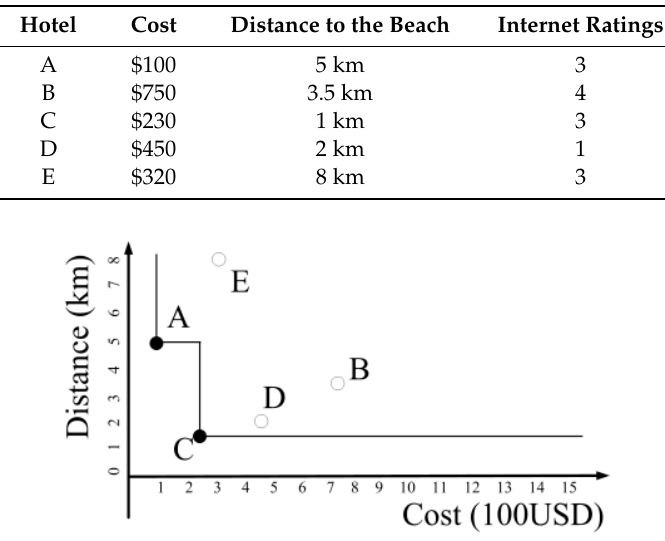
Table 2. Information pertaining to hotels in the vicinity of the beach.